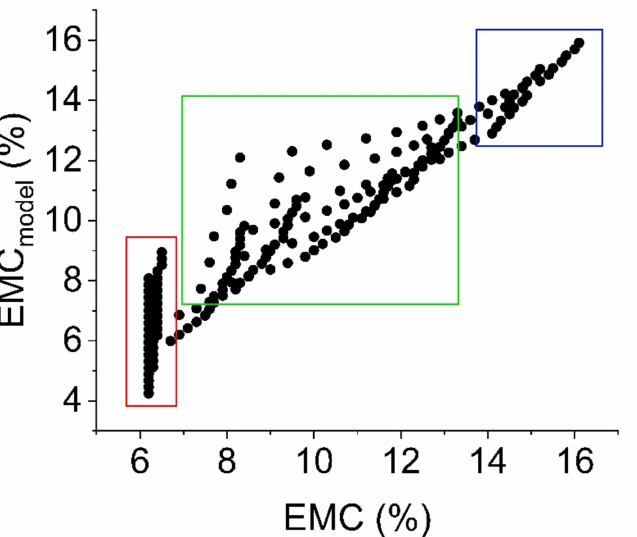
Figure 13. The selected linear multiple regression model (Equation (5)). On the abscissa, the EMC as calculated by Giordano, on the ordinate, the modelled EMC (unit %). The three boxes highlight areas that differ from each other. The red box indicates a first set of data with EMC = 6%; the green box highlights a central dataset with 7% < EMC < 13%; the blue box indicates a quasi-linear dataset with EMC >